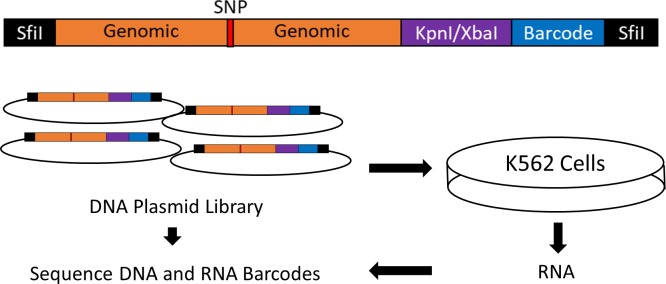
Design of the massively parallel reporter assay.A library of oligonucleotides was designed and synthesized containing CD36 eQTL SNPs surrounded by 150bp of genomic context 5’ to a KpnI/XbaI linker used to insert a minimal promoter-luciferase cassette derived from pNL3.2. 3’ to the linker is a unique 10bp barcode. SfiI restriction sites generated by PCR were used to clone the oligo into the pMPRA1 backbone vector. The plasmid library was transfected into K562 cells and 48 hours RNA was harvested. Barcodes from the harvested RNA and plasmid DNA library was quantified by NGS.